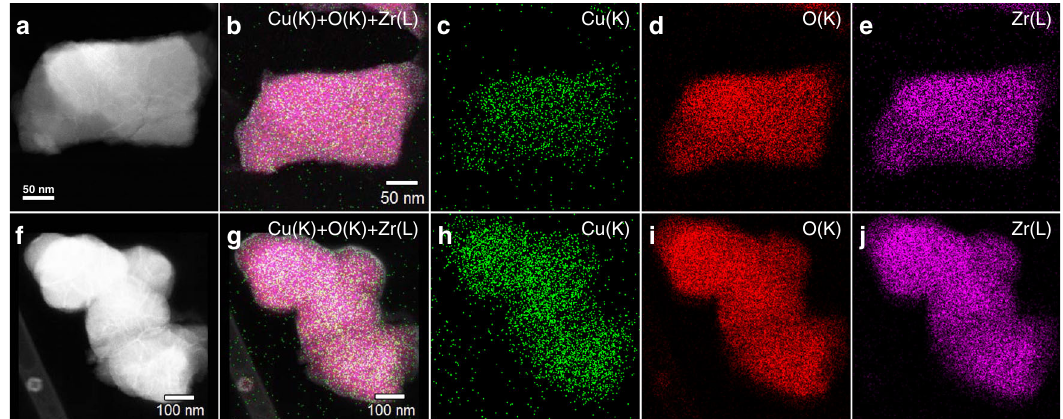
Fig. 3 Microscopy characterization of Cu/UiO-66-a. HAADF-STEM-EDX images ( a – e ) of Cu/UiO-66-a showing the homogeneous distribution of Cu and Zr. The HAADF-STEM-EDX images ( f – j ) of Cu/UiO-66-a used at 250 °C show that the distributions of Cu and Zr within UiO-66 remain homogeneous after